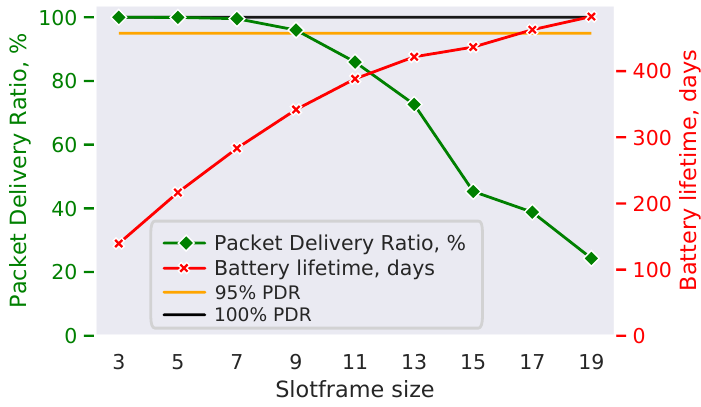
Figure 12. Parameter sweep